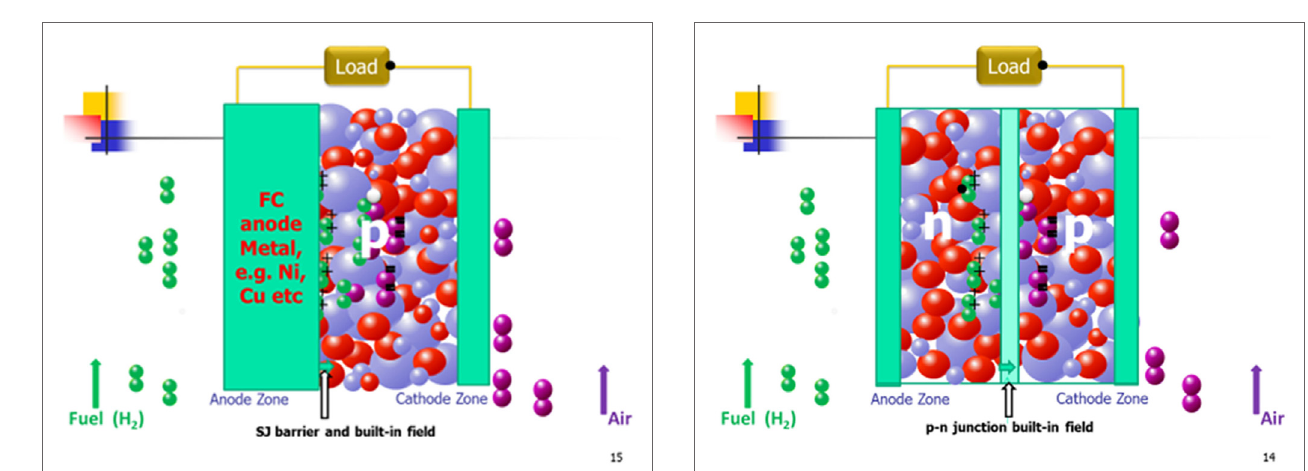
FiGURe 8 | The eFFC with the Shottky junction barrier built on p-type semiconductor and working principle (black ball: e − charge; white ball: hole charge; green ball + : H + ; purple ball = : O 2 = ; blue and red balls simply semiconductor-ionic material) .